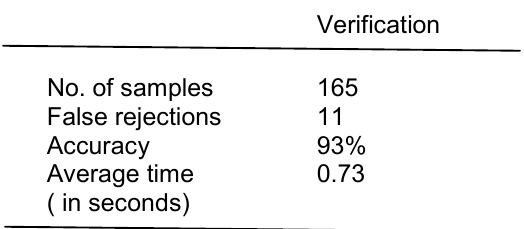
Table 2: Performance of verification